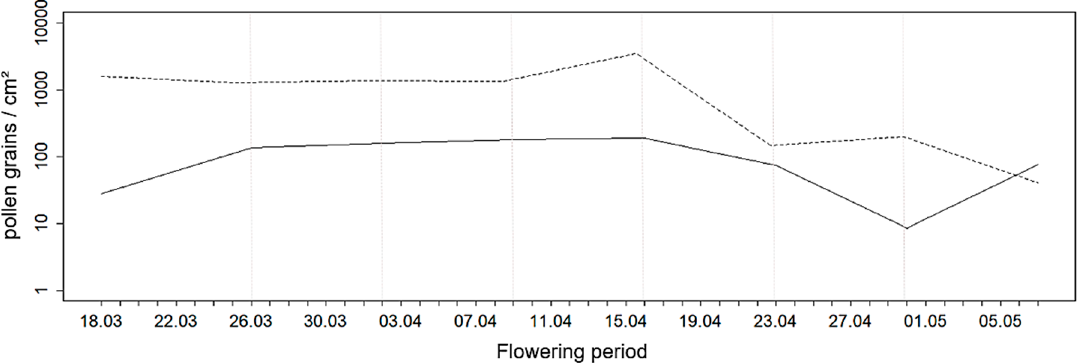
Table 1. Classification of pollen seasons for the seed plantation Schorndorf in 2019 and 2020.